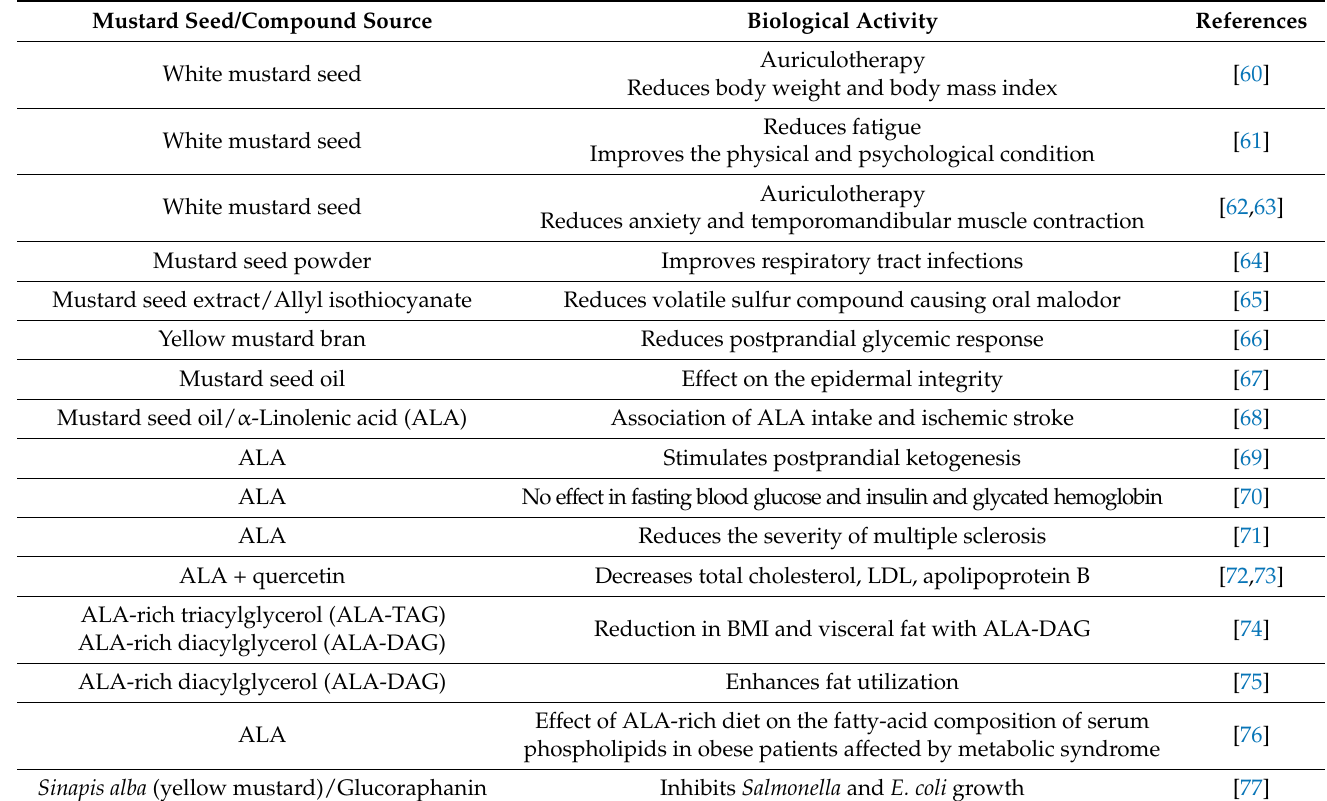
Table 2. Importance of glucosinolates and omega-3 fatty acids with respect to health